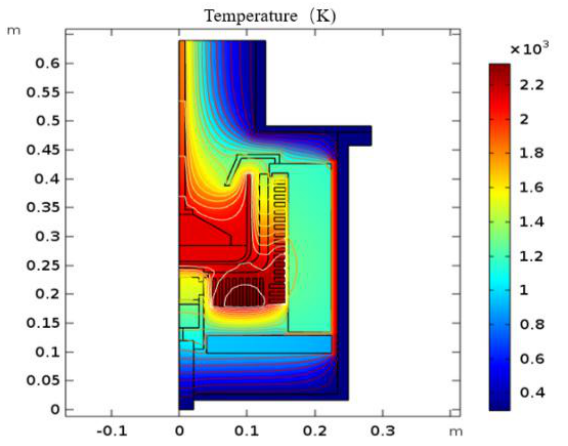
Figure 3. Temperature distribution in the process